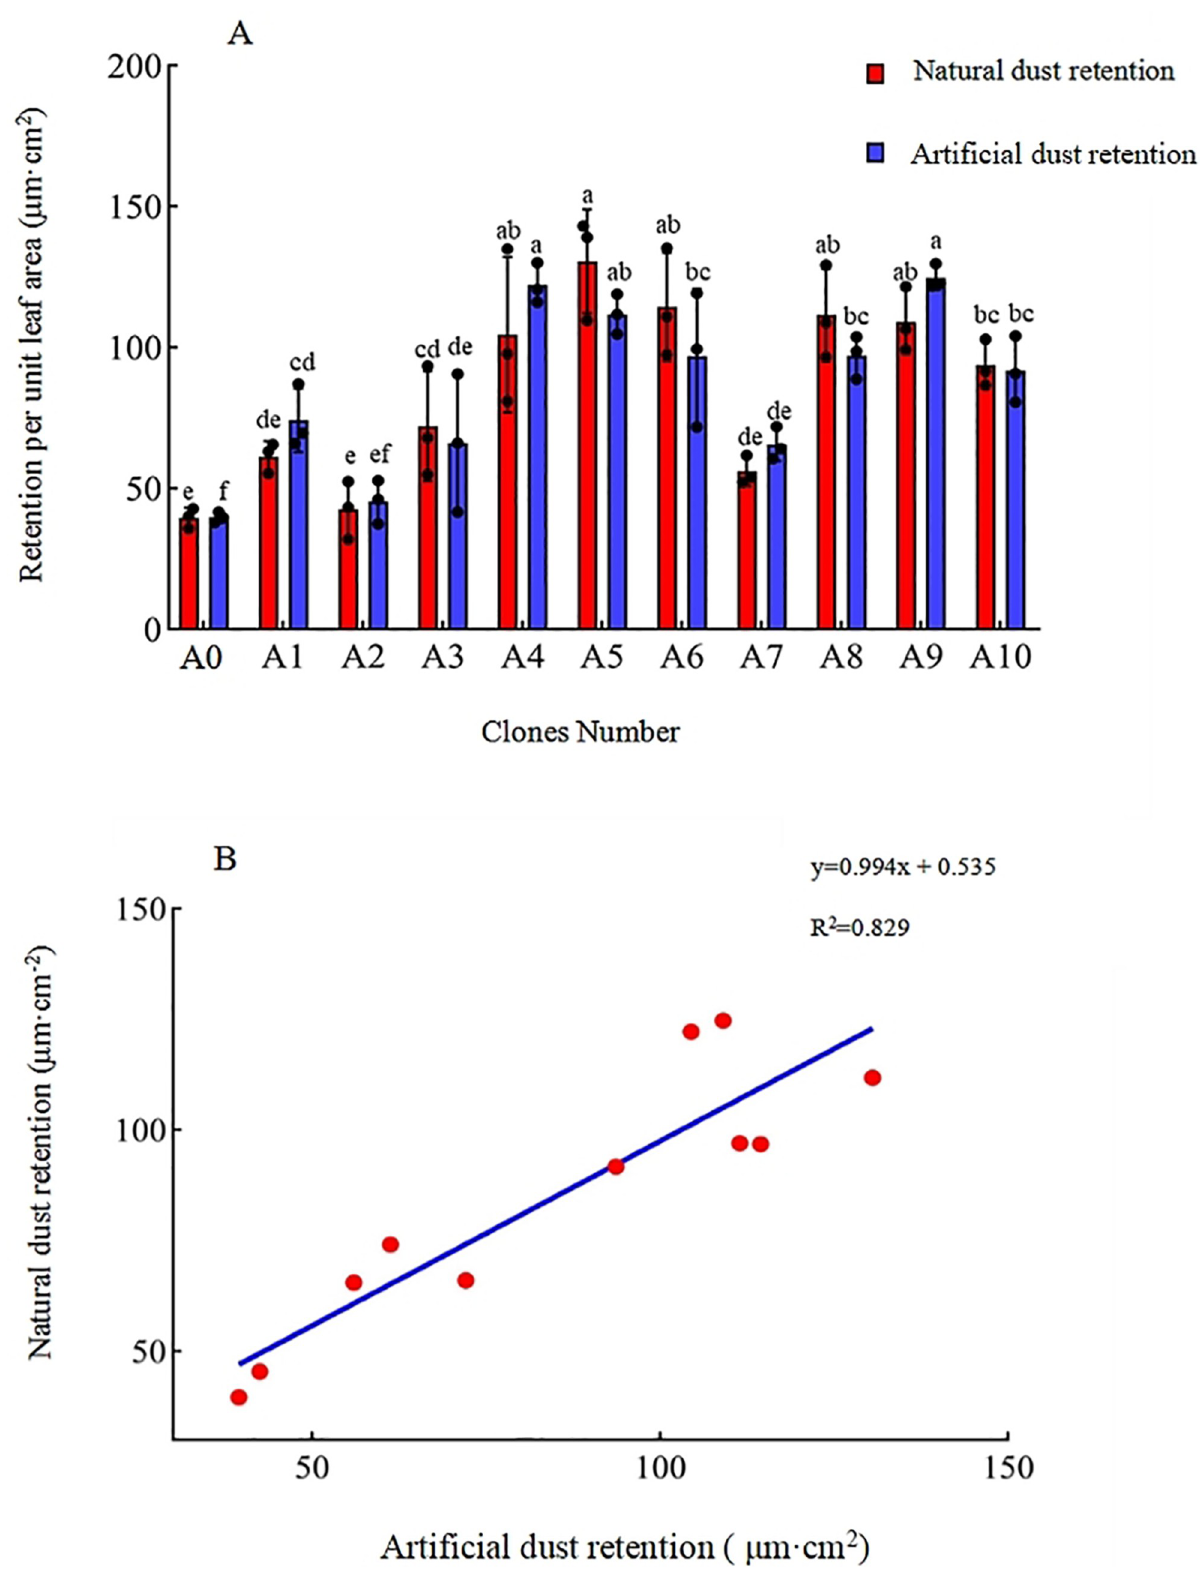
Fig 1. Retention capacity of total particulate matter in leaves of different clones of Sophora japonica L. Data in 2A are means ± standard deviation. Different lowercase letters indicate significant differences among different clones using the same determination method ( p < 0.05). https://doi.org/10.1371/journal.pone.0254627.g001 PLOS ONE | https://doi.org/10.1371/journal.pone.0254627 September 7,